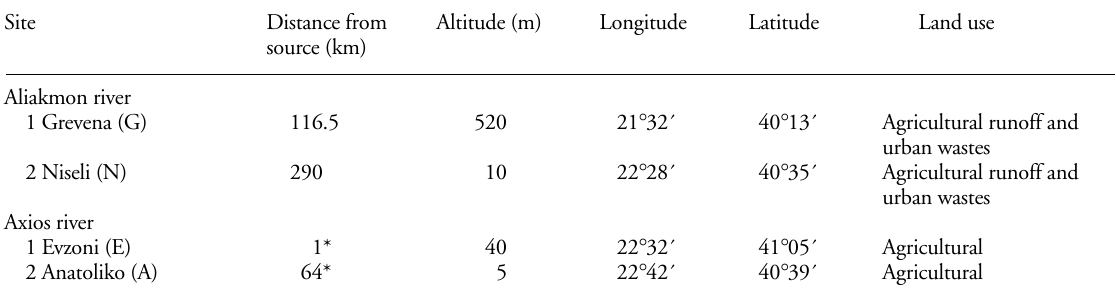
*This distance is calculated from the borders with